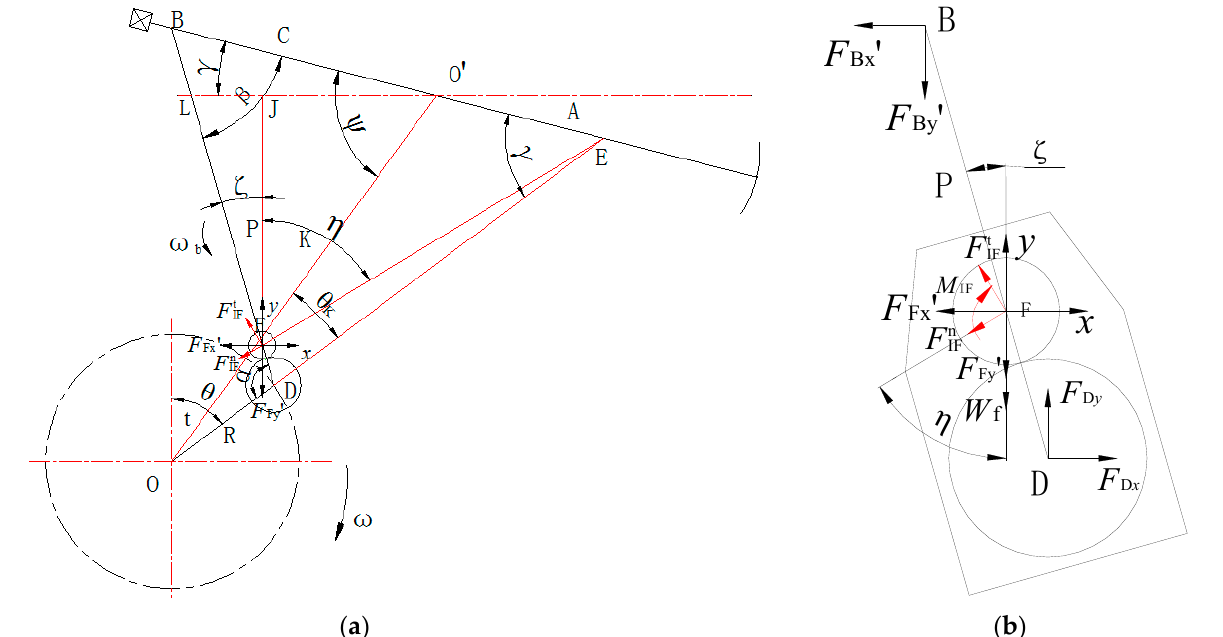
Figure 9. Force diagram of the linkage-speed increase gearbox: ( a ) complete analysis diagram of linkage-speed increase gearbox; ( b ) partial enlarged analysis diagram of linkage-speed increase gearbox.